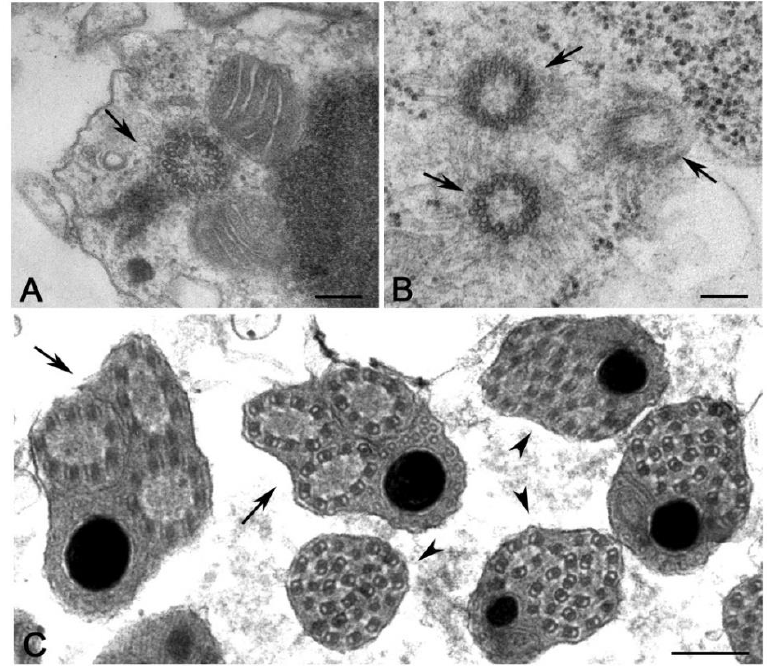
Figure 8. Abnormal male gametogenesis and supernumerary centrioles in differentiating spermatids. Details ( A ) of spermatids of the termite Reticulitermes with a pair of orthogonal centrioles (arrow) and ( B ) spermatids of the thrips Haplothrips showing three parallel centrioles (arrows) ( B ). ( C ) Each centriole in thrips spermatid organizes distinct axonemes (arrows) that fuse in a single large microtubule bundle (arrowheads). Bars 200 nm.